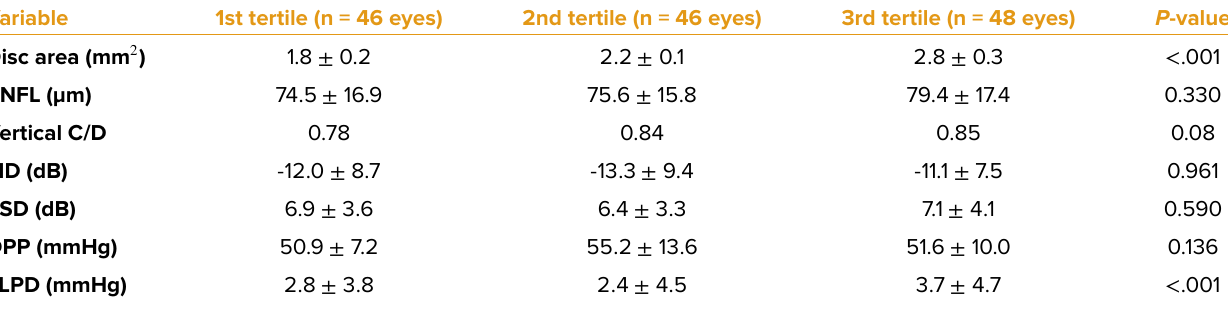
Table 2. Clinical characteristics of 140 eyes stratified by optic disc size. Variable 1st tertile (n = 46